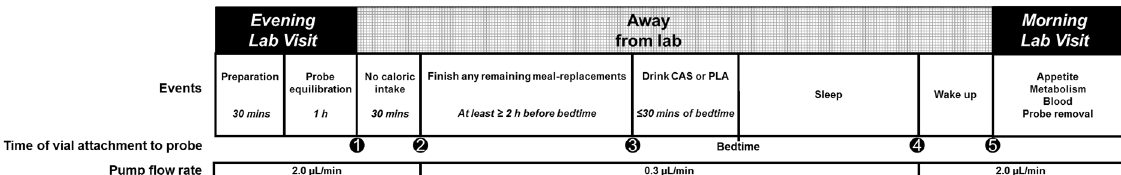
Figure 1. Overview of the trial period. CAS, casein; PLA, placebo. Each sample collection marker ( ‚ ) indicates the dialysate vial number and the time when the vials were attached to the exit end of each probe (i.e., vial 1 was worn immediately post-equilibration for 30 min). Dialysate samples of interest were the overnight and immediate next morning samples (markers 3 and 4).